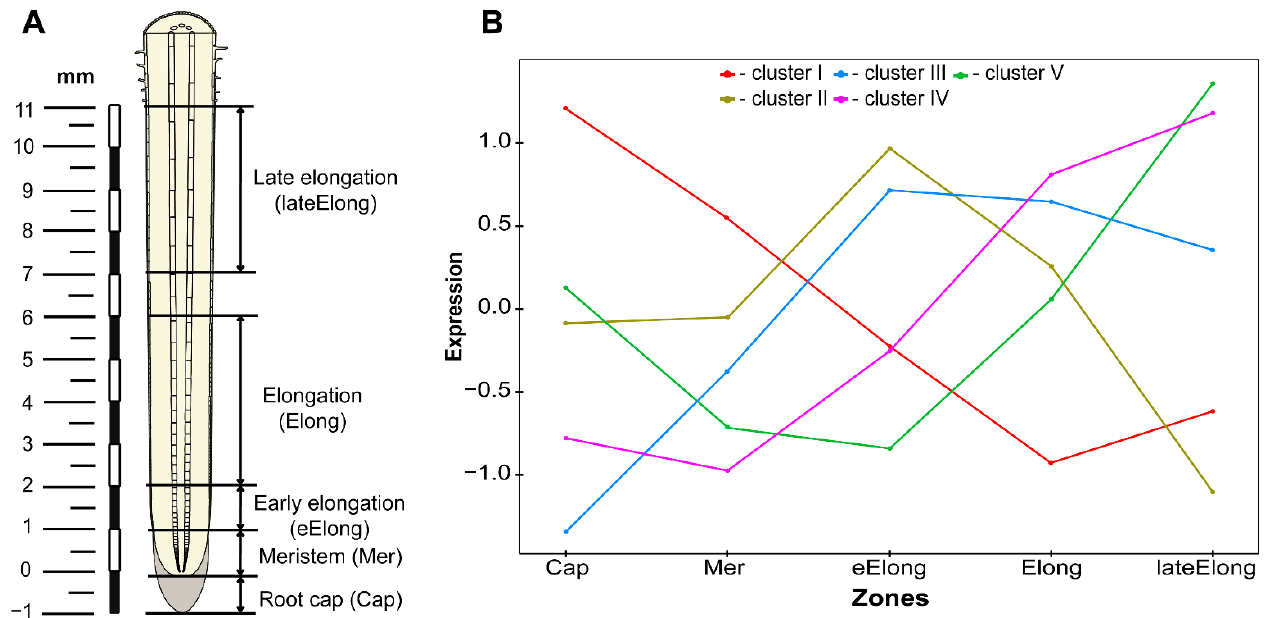
Figure 1. Schematic representation of the maize root zones under study ( A ) and the averaged gene expression profile of the different clusters by zone ( B ).